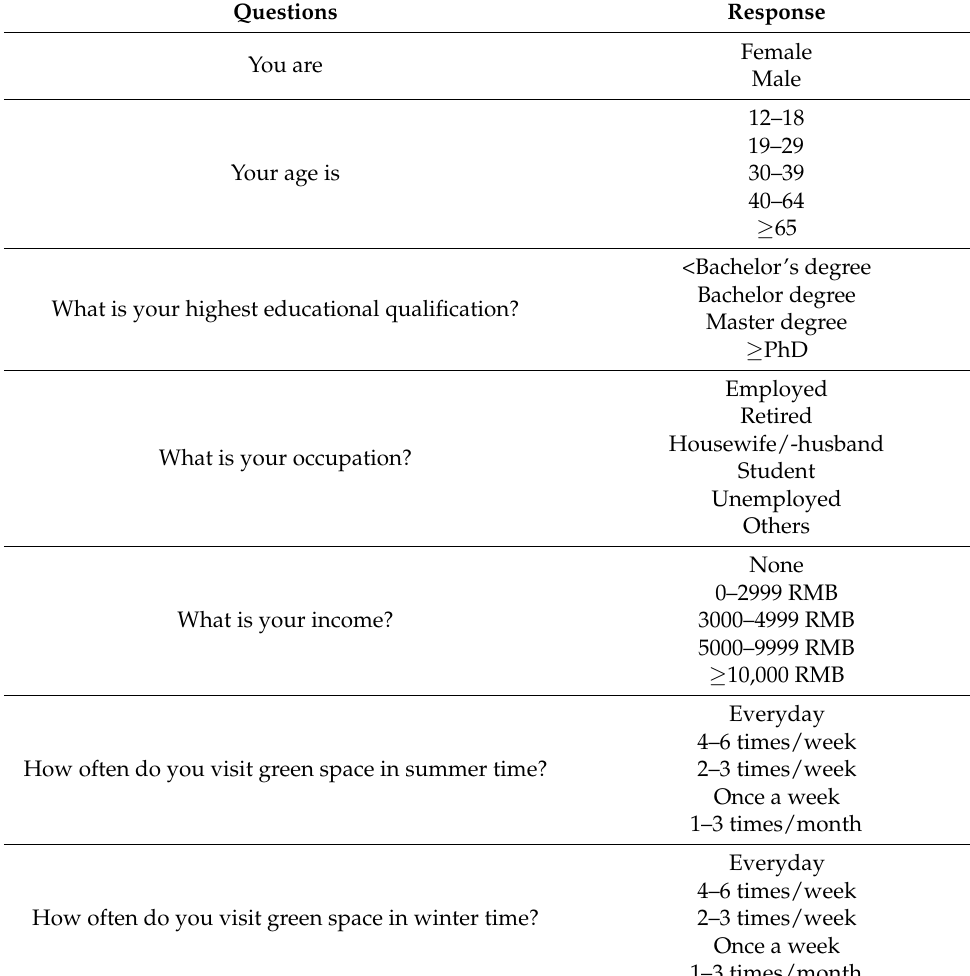
Table A2. Socio-demographic backgrounds of participants (as the respondents are Chinese, we trans- lated the questionnaire to Chinese, and then translated the results into English for the convenience of readers of this